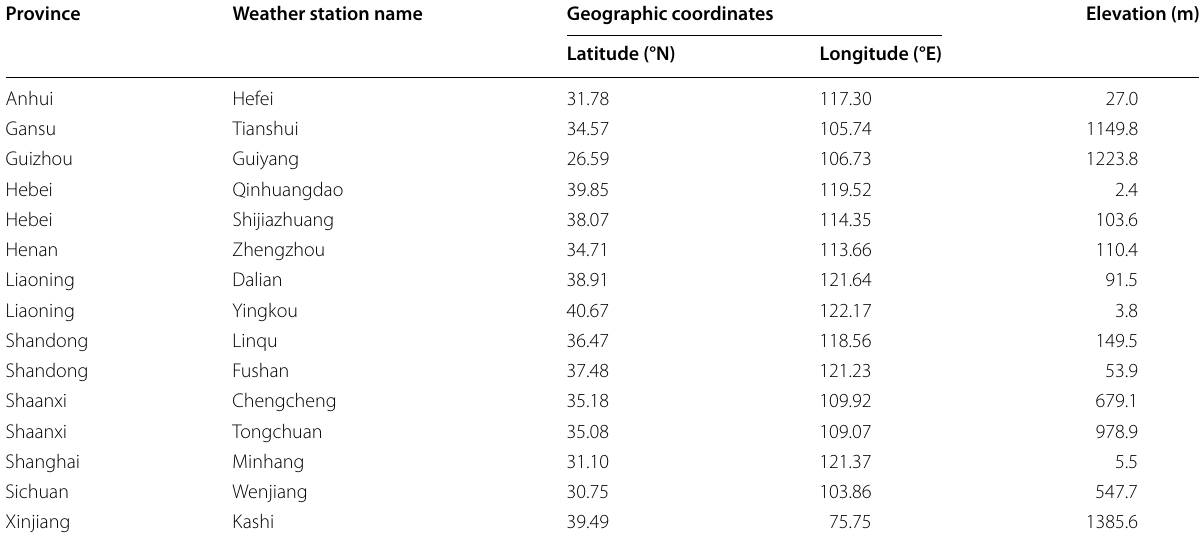
Table 1 Weather stations used as primary sources of precipitation data in China Province Weather station